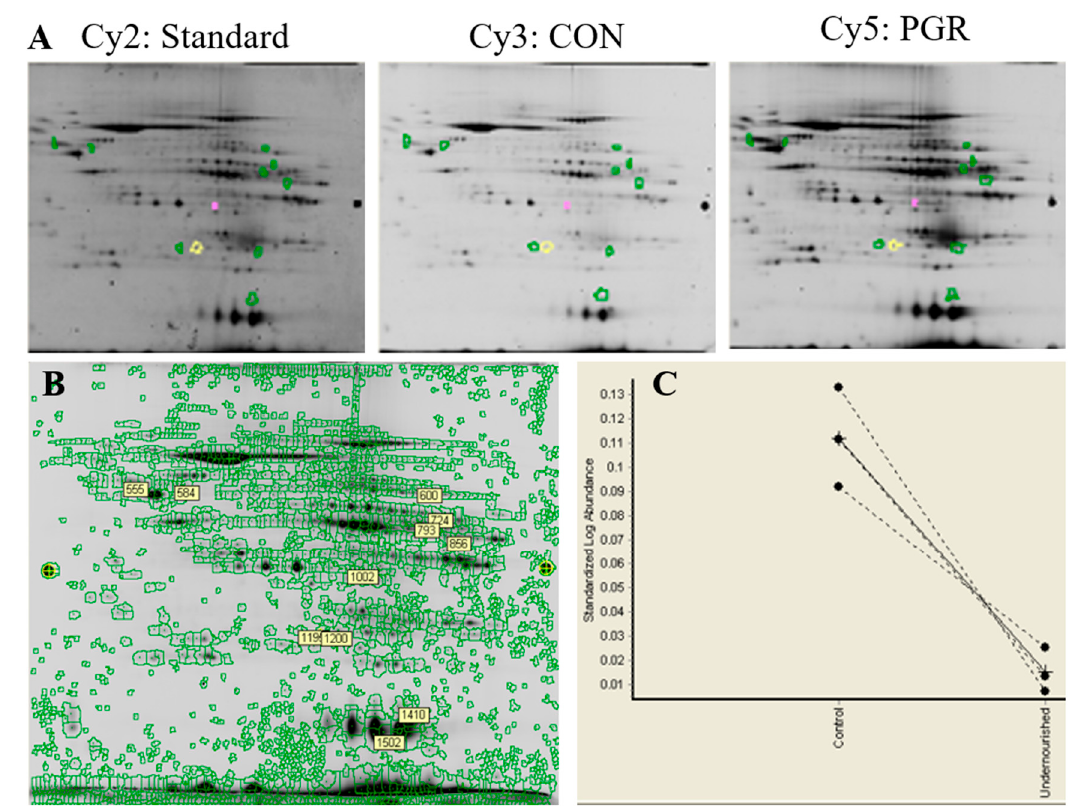
Figure 9. Representative image from DeCyder software: ( A ) Six gels were CyDye-labeled through 2D DIGE three-dye methodology. ( B ) Of the 2187 total spots identified, two spots were determined to have significant differential abundance ( p < 0.05); three spots with a p -value of 0.05–0.075 were also robotically picked and digested, illustrated by the green, yellow, and pink circles in panel A. ( C ) The graphical view from the DeCyder software shows the standardized log abundance between the CON and PGR of the protein spot that was selected.